Question: In a single sentence, describe what this figure presents.
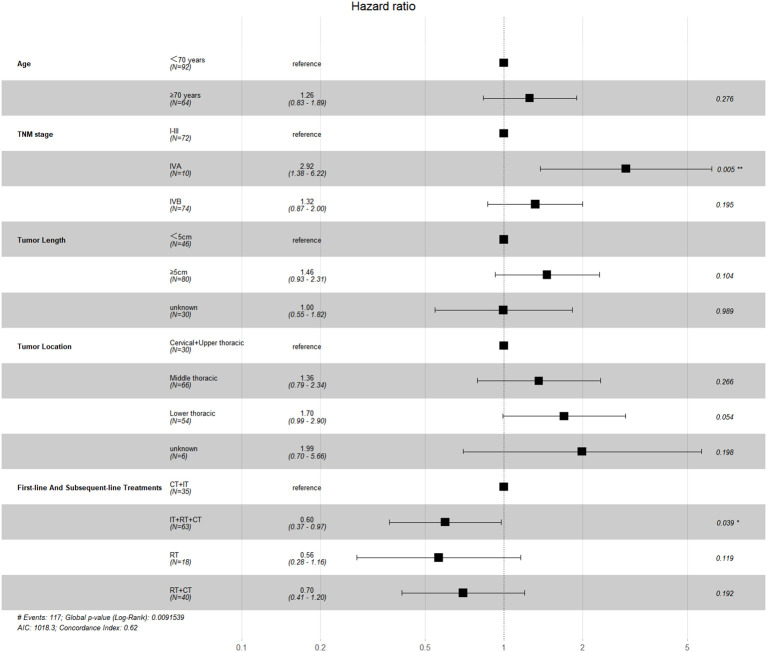
Answer: Multivariate Cox regression analysis for OS of 156 recurrent and/or distant ESCC patients. * P < 0.05, ** P < 0.01.